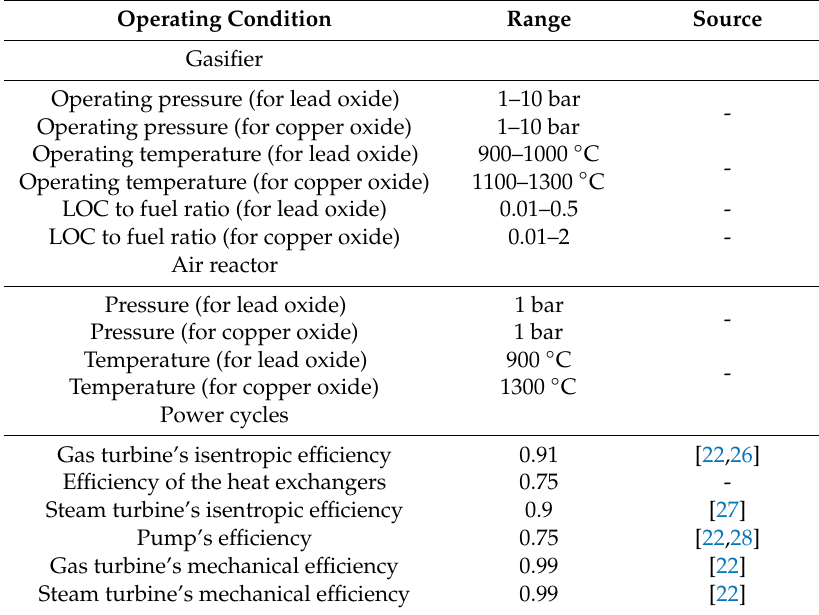
Table 1. Assumptions and reference conditions used in the simulation.